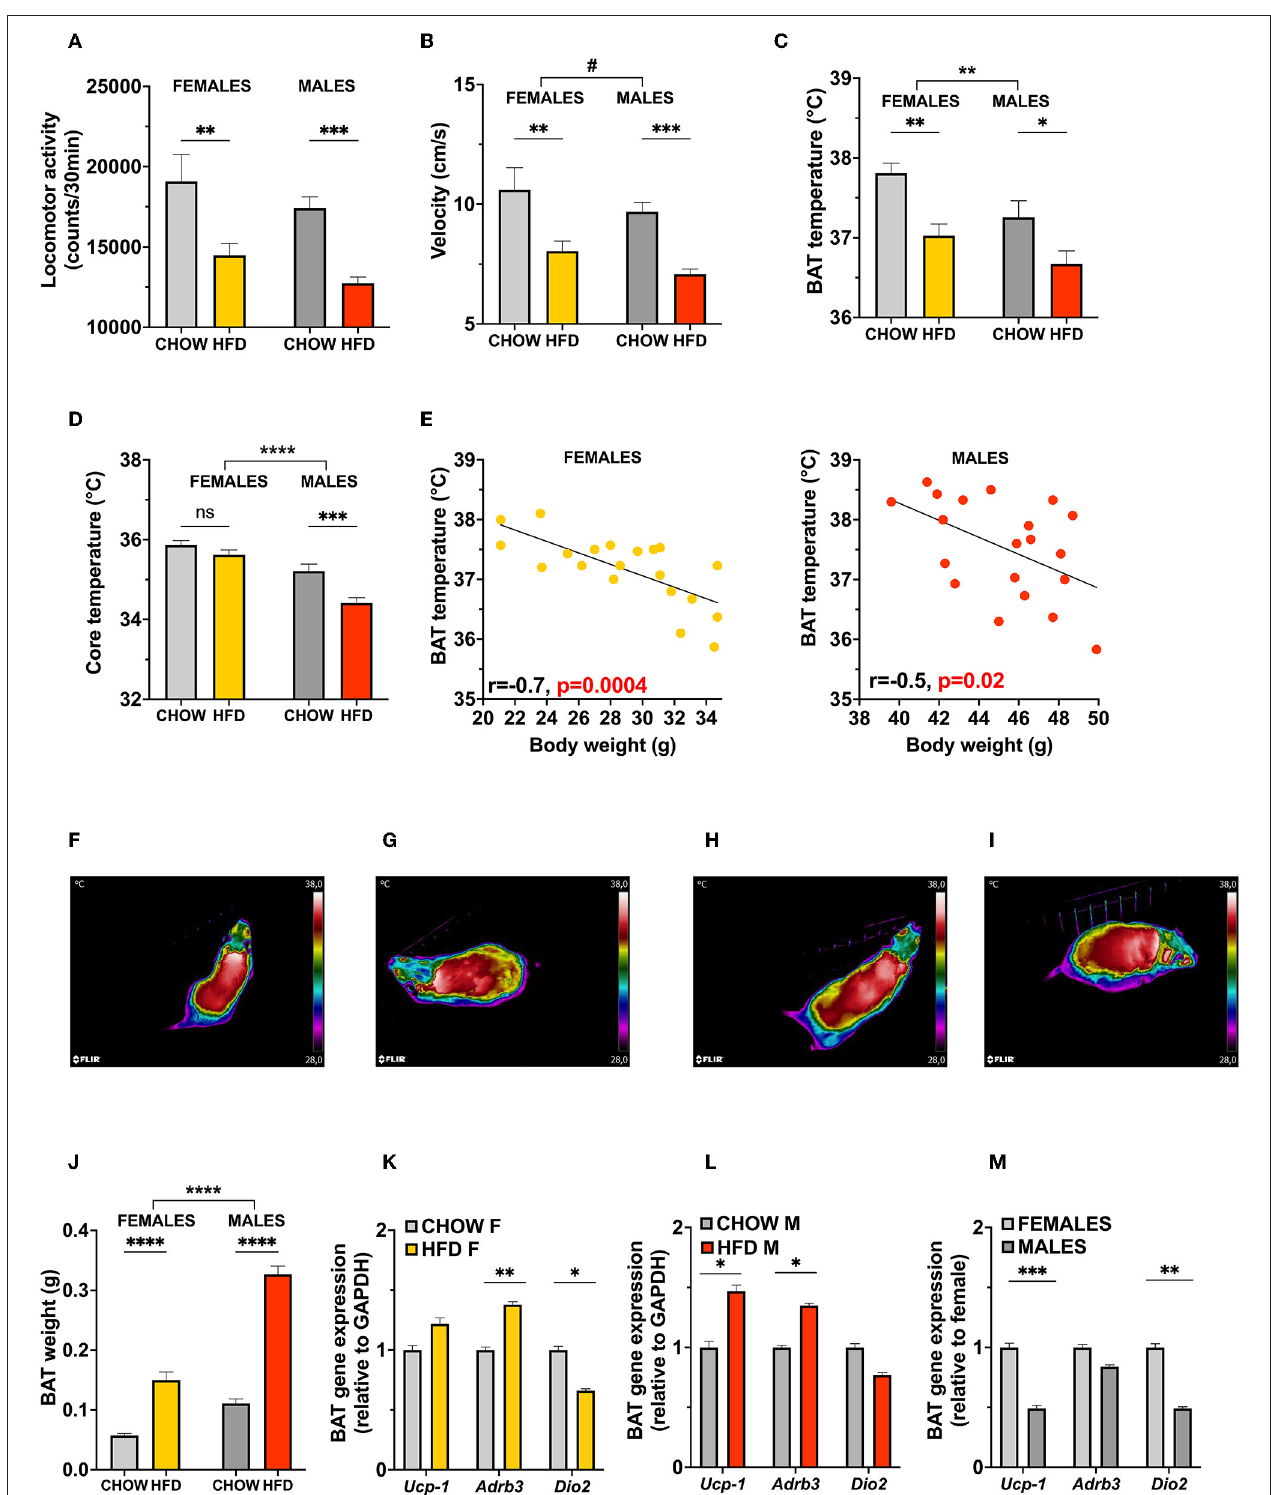
FIGURE 4 | Energy expenditure is reduced in obese male and female mice. Increased body weight of HFD mice lead to a reduction in locomotor activity (A) and velocity (B) in both males and females, with no significant differences found at baseline between the two sexes. In line with the sex-specific thermoregulation shown in rats, female mice displayed a higher basal BAT and core temperature (C,D) . However, an opposite effect of diet is observed in mice, where high-fat diet reduced BAT region temperature in both sexes (C) . Linear regressions of BAT temperature with body weight as a covariate in female and male mice on HFD ( E ; left and